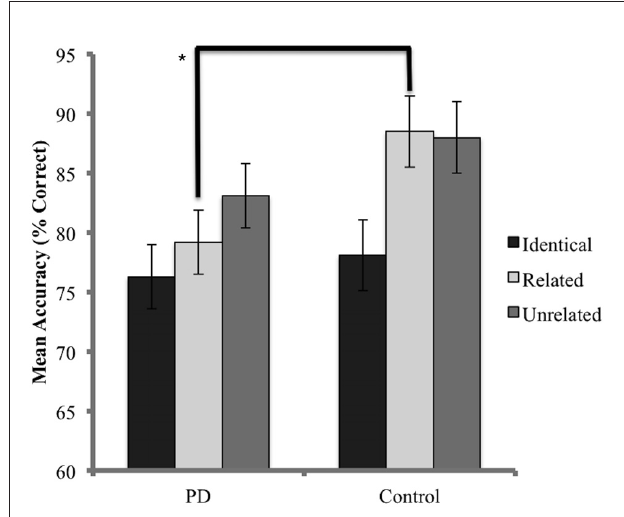
FIGURE 3 | Mean accuracy (percentage correct) for probe responses in identical, related, and unrelated conditions for each group. Brackets indicate a significant difference ( ∗ p < 0.05). Error bars indicate mean standard